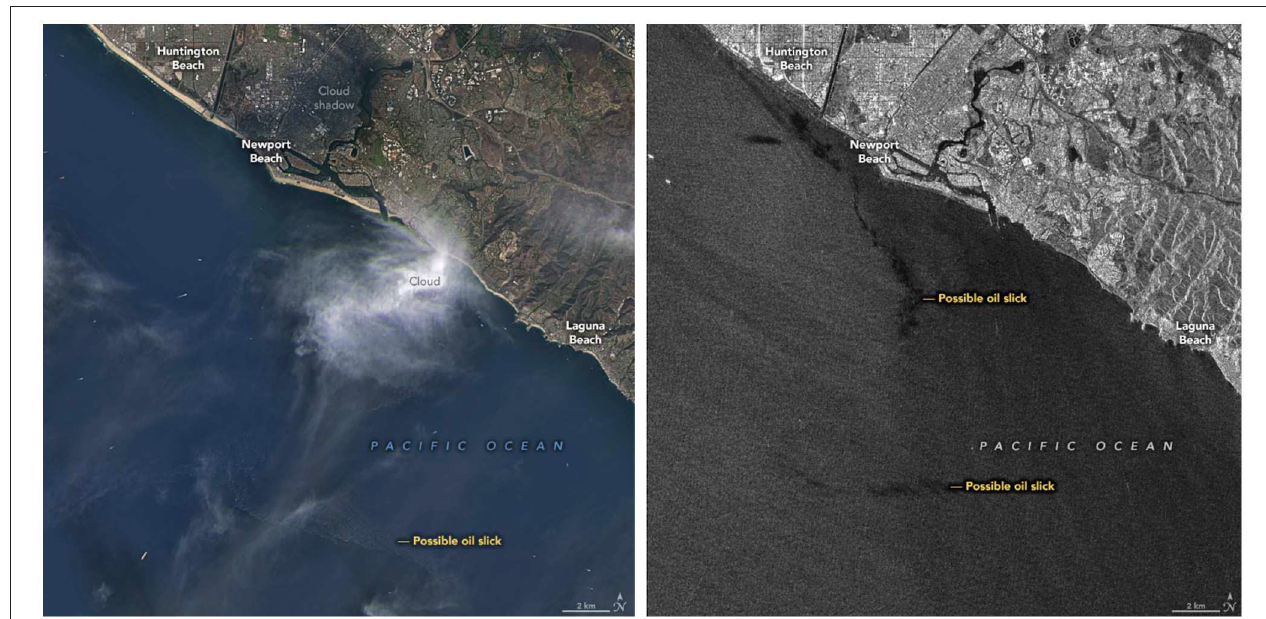
FIGURE 6 | Satellites were able to spot an oil slick from a major oil spill in Southern California in 2021. (L) is an image from October 2, 2021, from OLI on Landsat 8, and (R) is a SAR image from the ESA Sentinel-1B satellite. [Credit: NASA Earth Observatory image by Joshua Stevens, using Landsat data from the U.S. Geological Survey and modified Copernicus Sentinel data processed by the ESA ( NASA Earth Observatory, 2021b)].